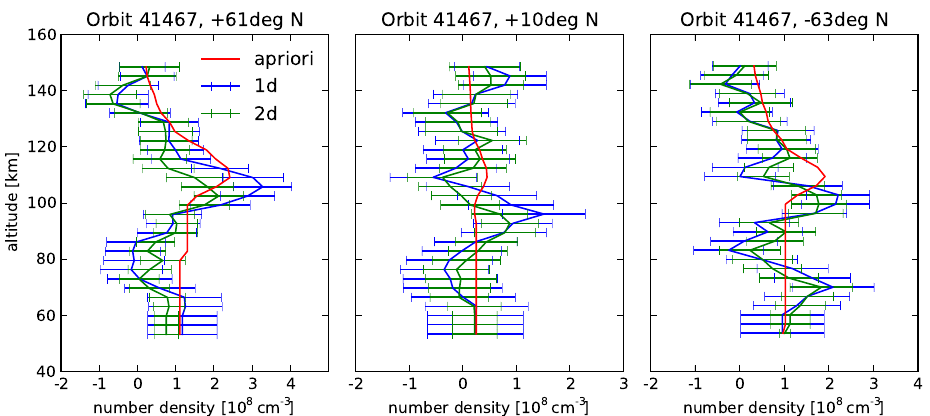
Fig. 10. Comparison of retrieval methods, 1-D retrieval (blue line), 2-D retrieval (green line), and the respective a priori input (red line) for three geographic regions of the selected sample orbit (no. 41467, 3 February 2010).